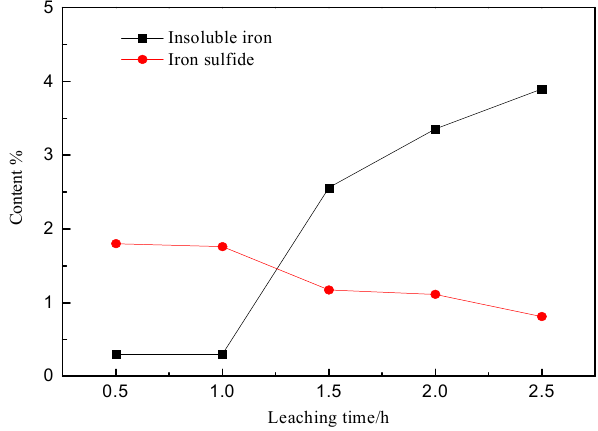
Figure 13. The content of different iron phase in the leach residue with the leaching time.